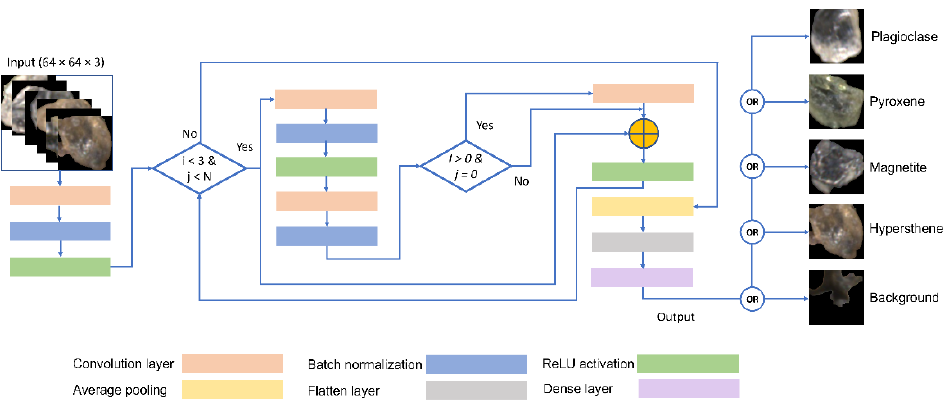
Figure 9. ResNet version 1 architecture for mineral